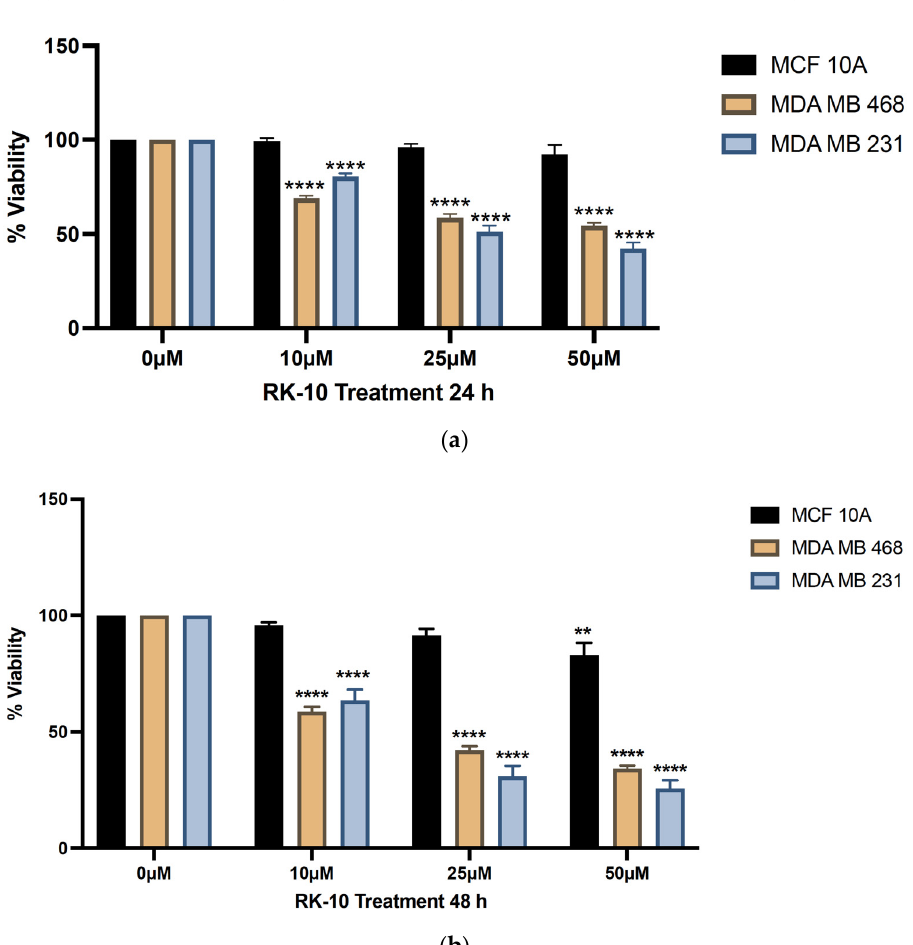
Figure 3. RK-10 inhibits the proliferation of triple-negative breast cancer cells. The effect of RK-10 on the proliferation of MCF-10A, MDA-MB 231, and MDA-MB 468 cells was evaluated after ( a ) 24 and ( b ) 48 h. Student’s t -tests were performed and treatments were compared to the DMSO control. Results are expressed as the means ± SDs (**** p < 0.0001, ** p < 0.01) and the data are representative, from one of at least three independent experiments.